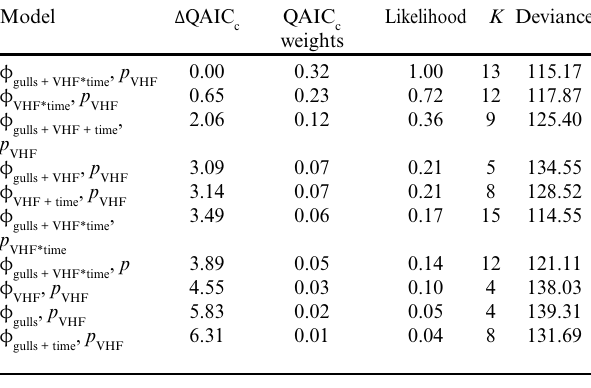
Table 2 . Modeling effects of gull presence and very high frequency (VHF) tags on apparent survival ( ϕ ) and recapture ( p ) probabilities of adult Leach’s Storm-petrels ( Oceanodroma leucorhoa ) on Bon Portage Island, Nova Scotia, Canada, 2009 to 2014 (values corrected for minor overdispersion; ĉ = 1.09). is the difference between a given model and the model Δ QAIC c with the lowest Quasi-Akaike’s Information Criterion (QAIC) value, and K is the number of parameters. Only models with QAIC weights ≥ 0.01 are included in this table. Note that 2 out c of 12 plots were occupied by 3-4 pairs of Herring Gulls ( Larus argentatus ) and their